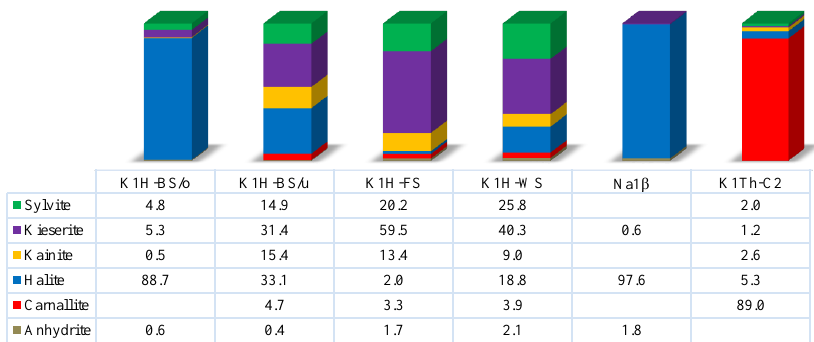
Figure 3. Mineralogical composition of test specimens (mineral concentrations in